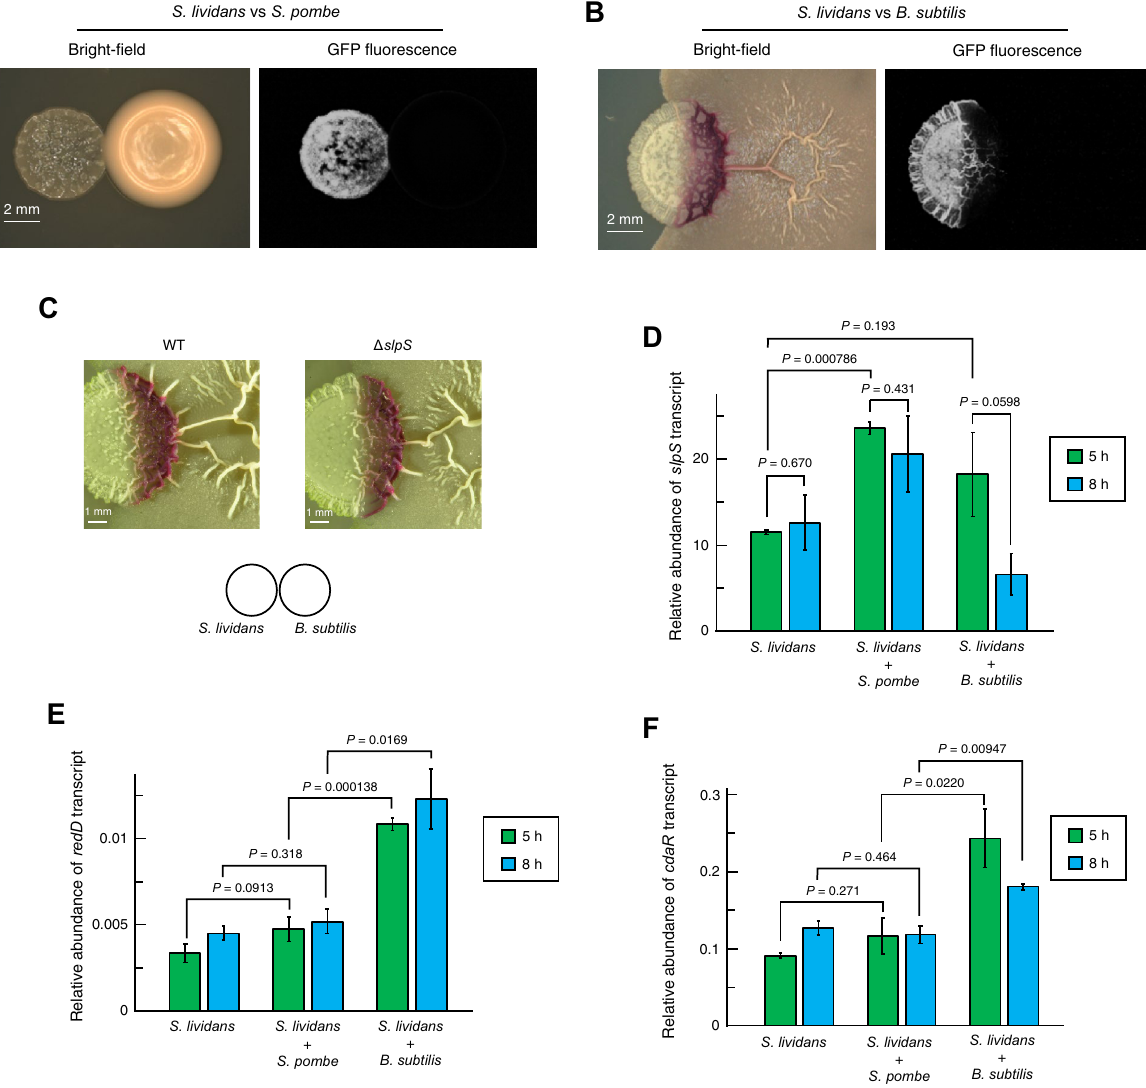
Figure 5. Patterns of SLP expression and antibiotic production by S. lividans in response to microbial competitions. Microscopic and transcriptional analysis revealed the differential response of S. lividans to the competitive interactions. S. lividans expressing SlpS-msfGFP was co-cultured with ( A ) S. pombe and ( B ) B. subtilis 168. Scale bars, 2 mm. ( C ) Colony boundaries between B. subtilis and S. lividans (TK23 strain and Δ slpS mutant) were observed. Scale bars, 1 mm. Relative transcription levels of ( D ) slpS , ( E ) redD , and ( F ) cdaR were compared among the different culture conditions. The amounts of the transcripts were normalized to the transcription level of hrdB encoding RNA polymerase principal sigma factor B. All values and the bars represent the mean value ± S.D. for three independent cultures. P values were calculated by t test with Welch’s